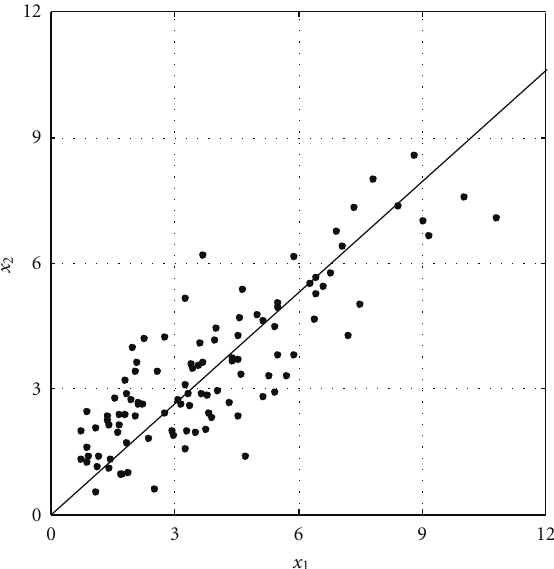
Figure 6: Remaining samples after selection, with ρ t = 0 .